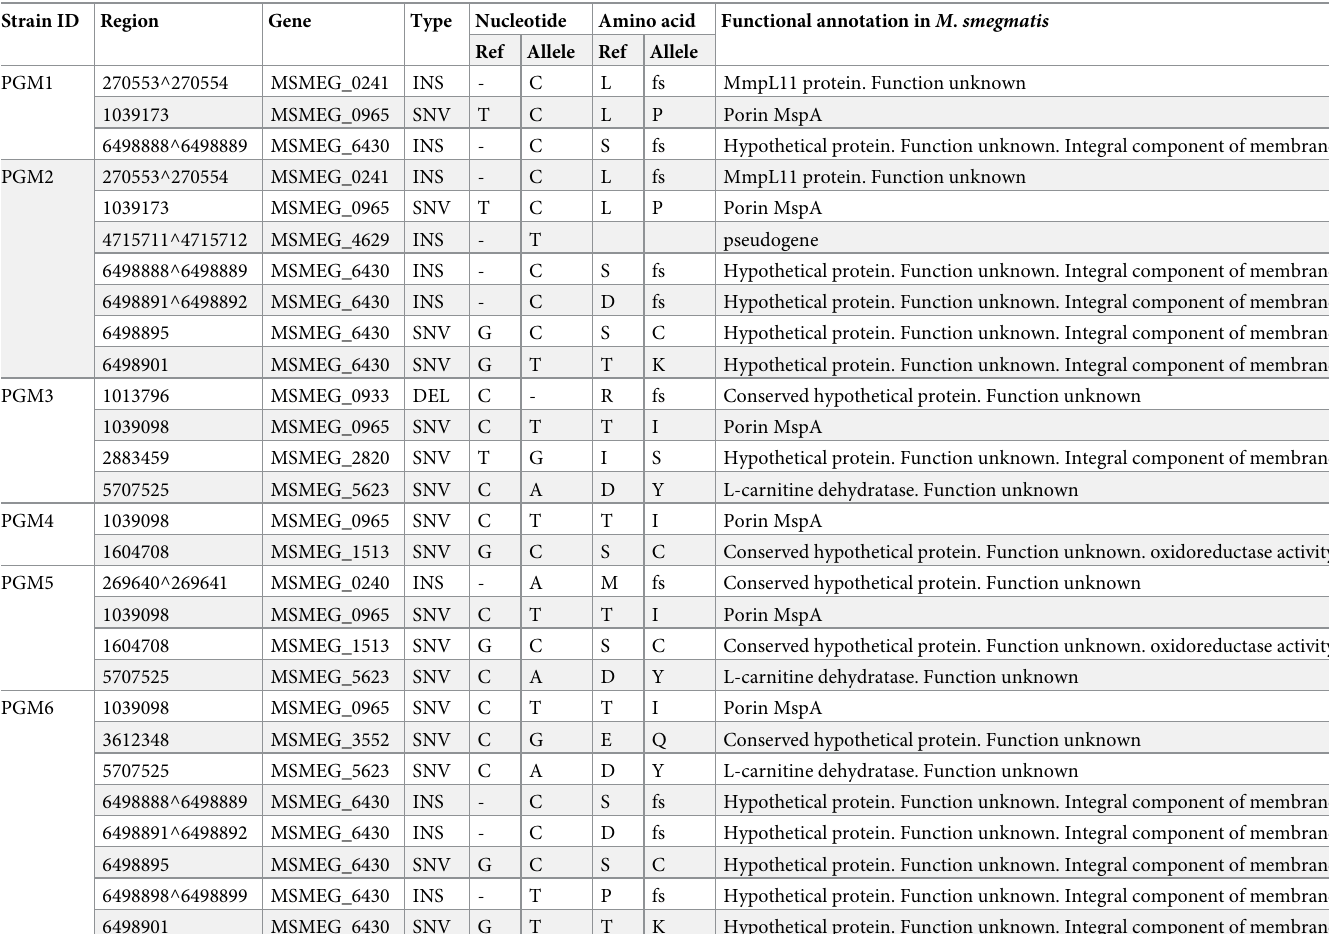
Table 2. Mutations identified in each FP-11g resistant mutant. Strain ID Region